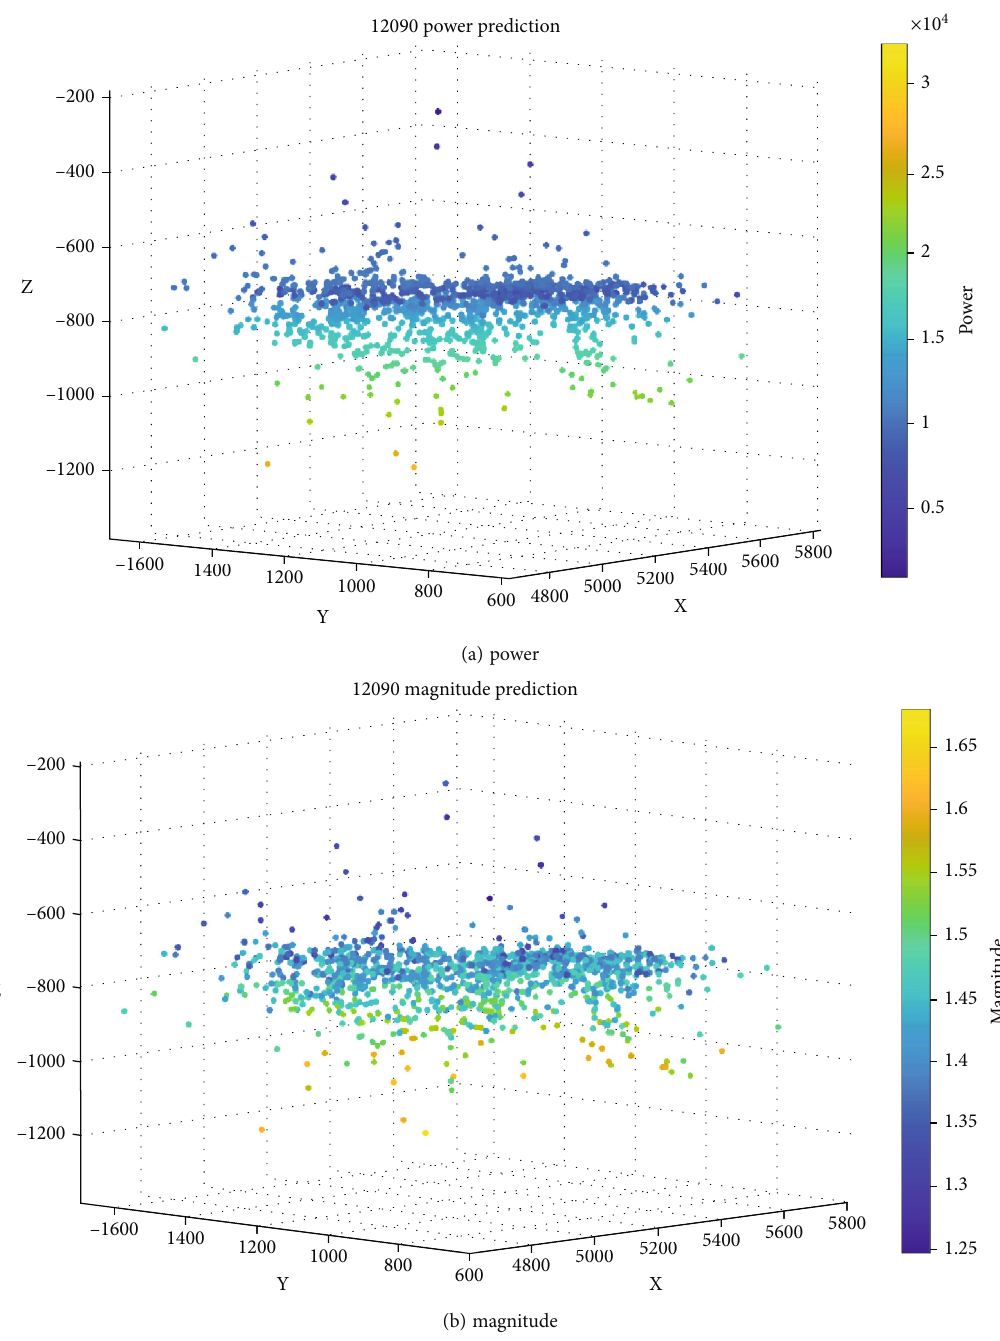
Figure 10: Prediction of power and magnitude of 12090 working face coal